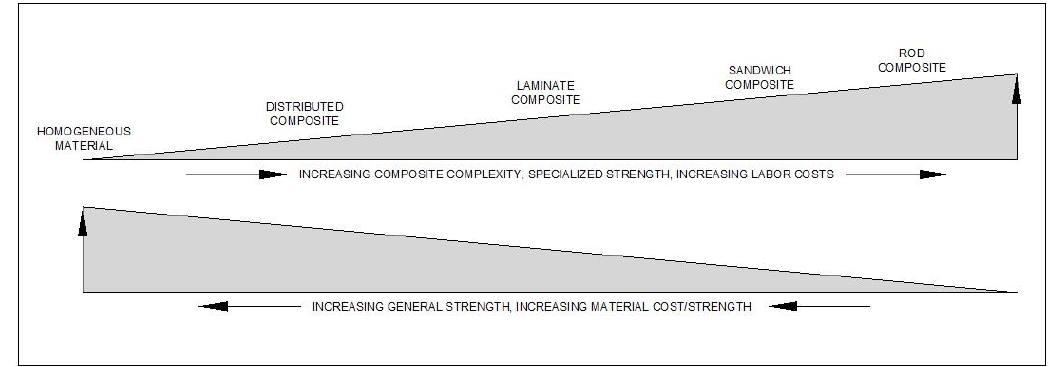
Figure 3. As material moves from being a homogenized material to an increasingly complex composite, several changes are made. While the strength becomes more specialized so too does the cost of construction per additional compositing item added. This, however, is offset by decreasing material costs per strength. The relative increases in specialized strength for beams greatly outweighs the disadvantage of the increased labor costs. An additional example is fiber-reinforced concrete; while it does have superior general strength, it cannot outperform steel-reinforced concrete for flexural requirements due to the advantages of locating the reinforcement at the extremities of a beam section.